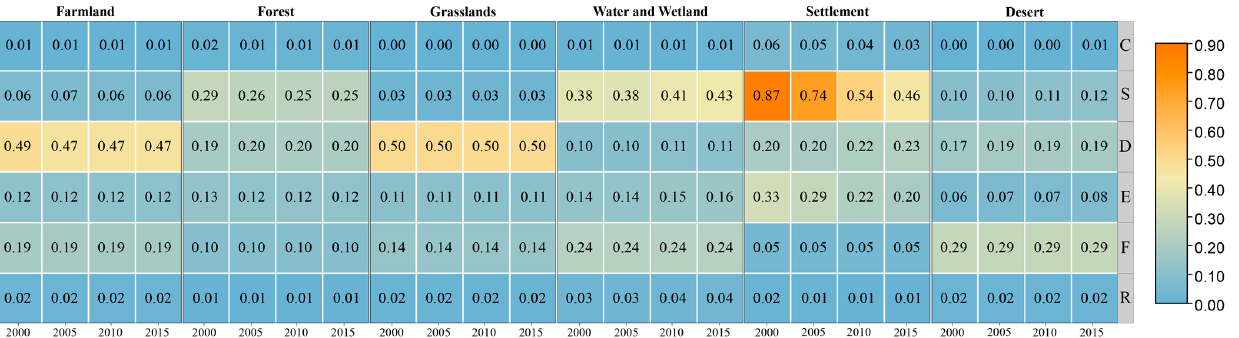
Figure 5. Heat map of landscape pattern index of each landscape type in Ningxia from 2000 to 2015.